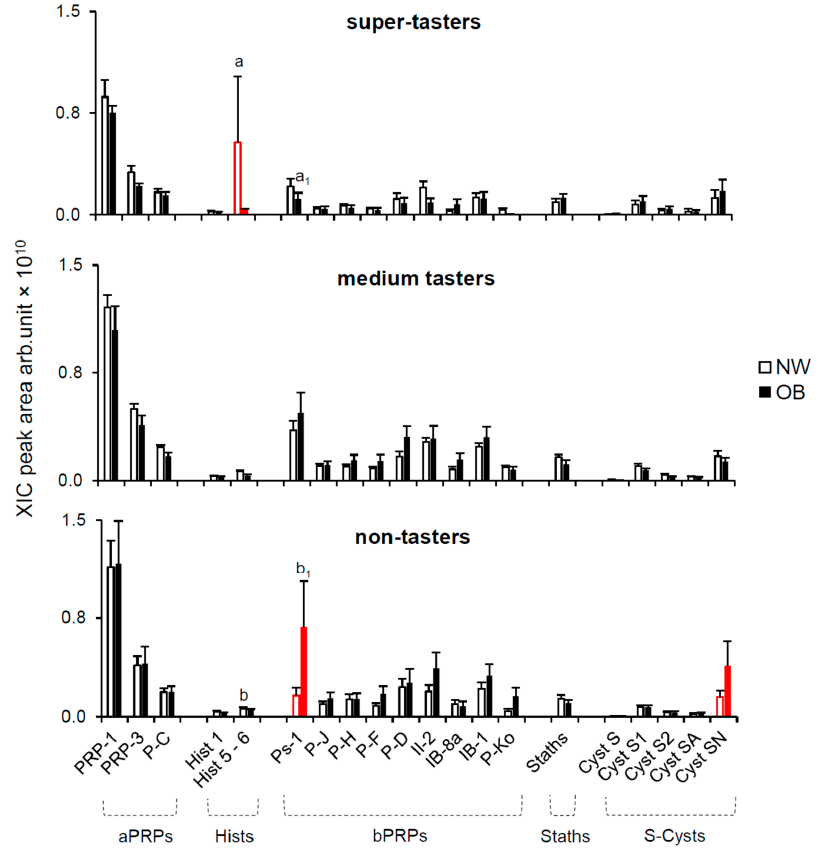
Figure 4. Mean values (±SEM) of the XIC peak areas of the PRP ‐ 1, PRP ‐ 3, P ‐ C, Hist 1, Hist 5 ‐ 6, Ps ‐ 1, P ‐ J, P ‐ H, P ‐ F, P ‐ D, II ‐ 2, IB ‐ 8a, IB ‐ 1, P ‐ Ko, Staths, Cyst S, Cyst S1, Cyst S2, Cyst SA and Cyst SN in unstimulated saliva of NW and OB according to PROP taster status. Non ‐ tasters: NW n = 22, OB n = 14; medium tasters: NW n = 29, OB n = 32 and super ‐ tasters NW n = 10, OB n = 11. Red color indicates a significant difference between NW and OB ( p ≤ 0.032; Fisher’s test LSD). a 1 , b 1 = significant difference between OB super ‐ tasters and non ‐ tasters; a, b = significant difference between NW super ‐ tasters and non ‐ tasters ( p ≤ 0.013; Fisher’s test LSD).